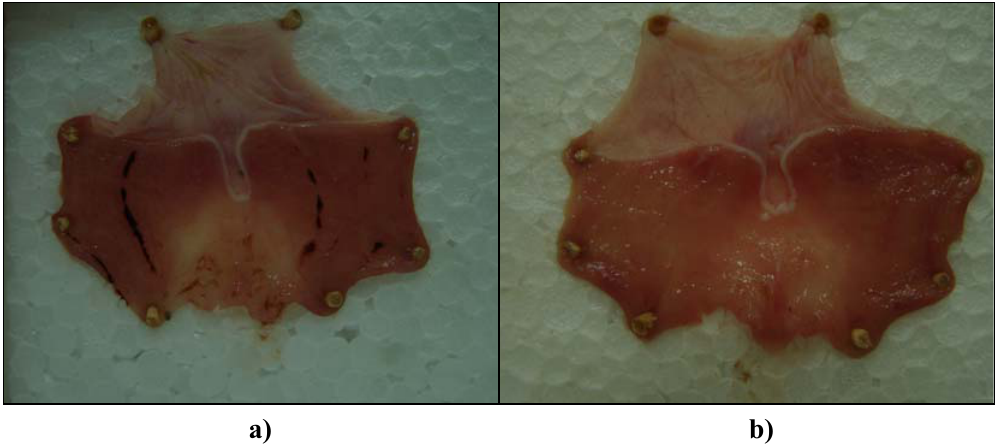
Figure 4. Effect on intragastric pretreatment with St. John’s Wort extracts E1, E2 and E3 (1.25 mL/kg) and quercetin (8 mg/kg) on the ulcer index induced by CRS. * indicates statistical significance in ulcer index, as compared to appropriate control value (C1, C2 and C3). # indicates statistical significance in ulcer index of E2, as compared to E1 and